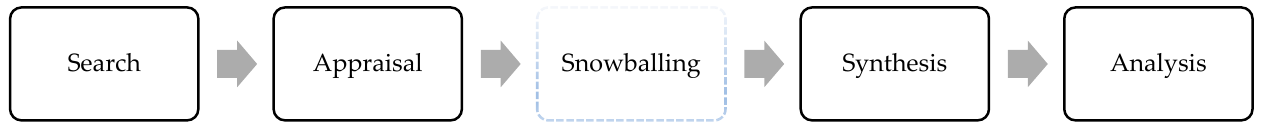
Figure 3. Framework of SALSA methodology. Source: authors.